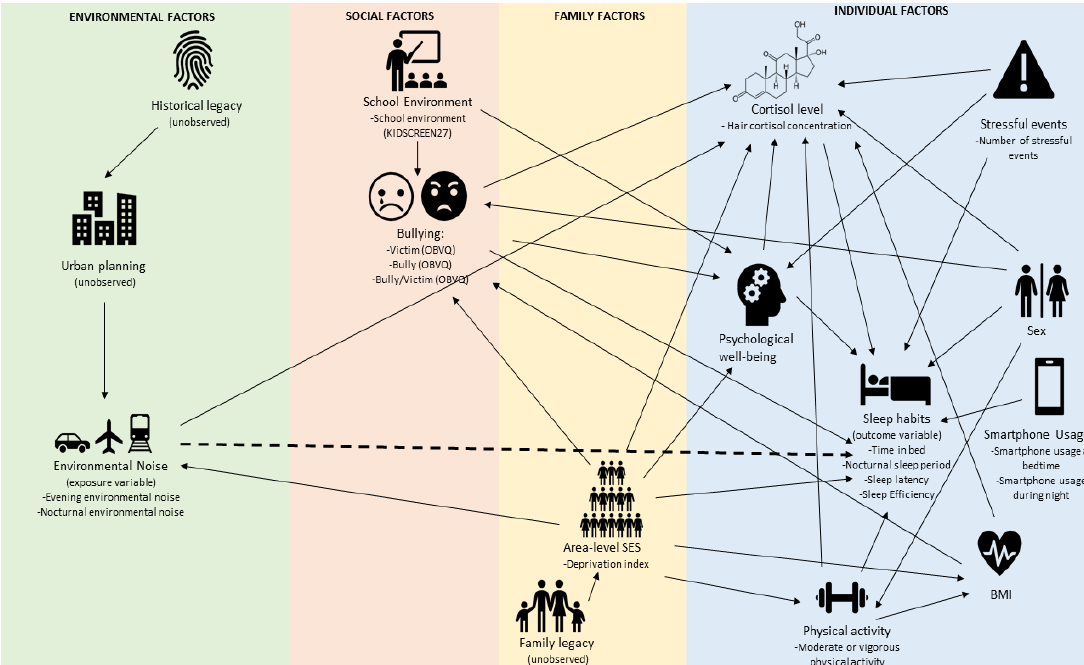
Figure 1. Directed Acyclic Graph (DAG) explaining the relationship between environmental noise and sleep habits in children. This model was used in the present study to test the effect of noise on children’s sleep (marked in dotted lines). Four sections are shown in the image in order to represent multiple levels of influence (ecological model); interactions between environmental, social, family and individual factors can alter children’s sleep habits (outcome variable). The variables and measurement scales used in each node are shown under the construct name. Environmental noise was considered an exposure variable in this study, and historical legacy, urban planning and family legacy were unobserved.